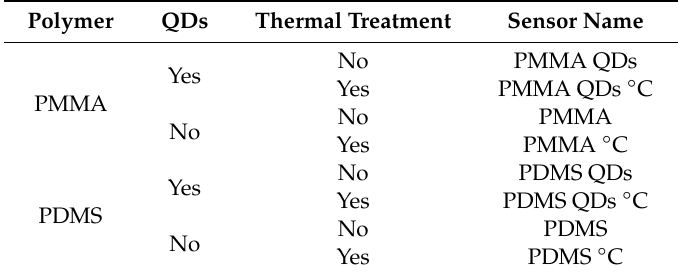
Table 1. The composition of sensitive layers of the sensors studied.